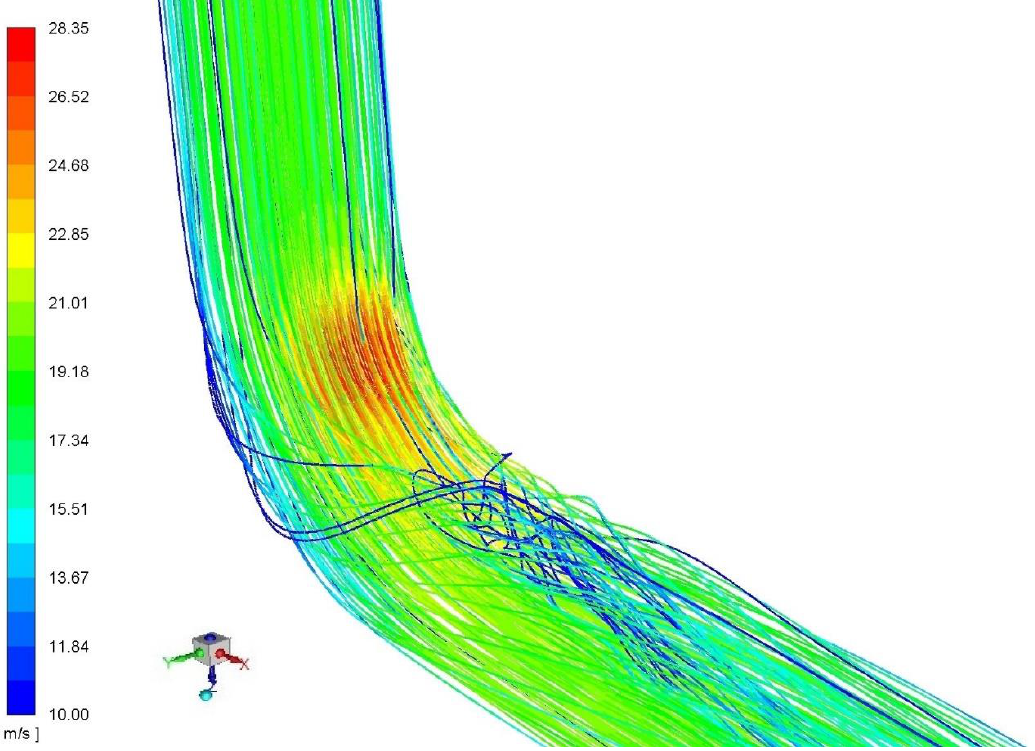
Figure 6. Unsteady flow through an elbow with a radius of curvature R c = 1D at mean velocity 18 m/s. INLET (at the inlet)– k = 1.22 m 2 / s 2 , ω = 189.4 1 / s, U x = 18.0 m / s, U y = 0; U z =